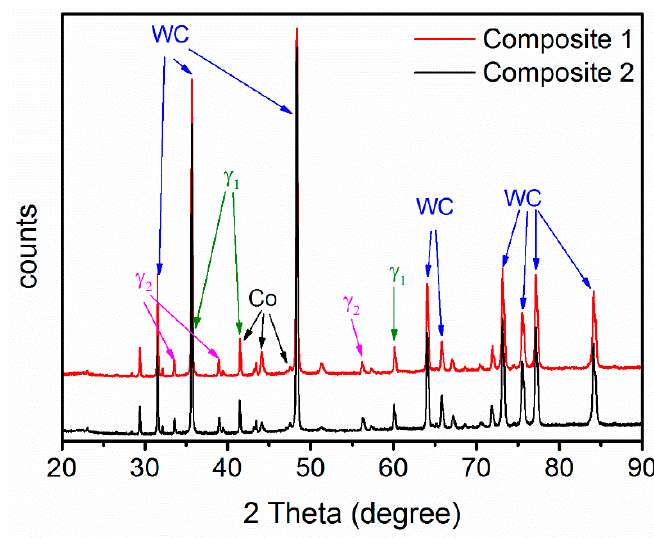
Figure 2. XRD patterns of composite 1 and 2 after sintering at 1410 °C for 1 h.